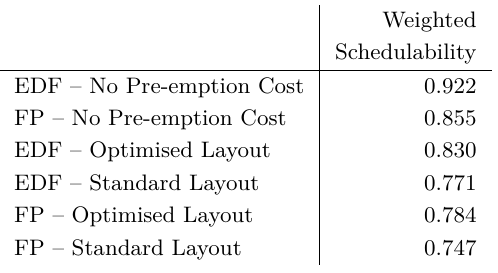
Table 4 Weighted schedulability measures for the mixed case study shown in Figure 8. The higher the weighted schedulability measure, the more tasksets deemed schedulable by the